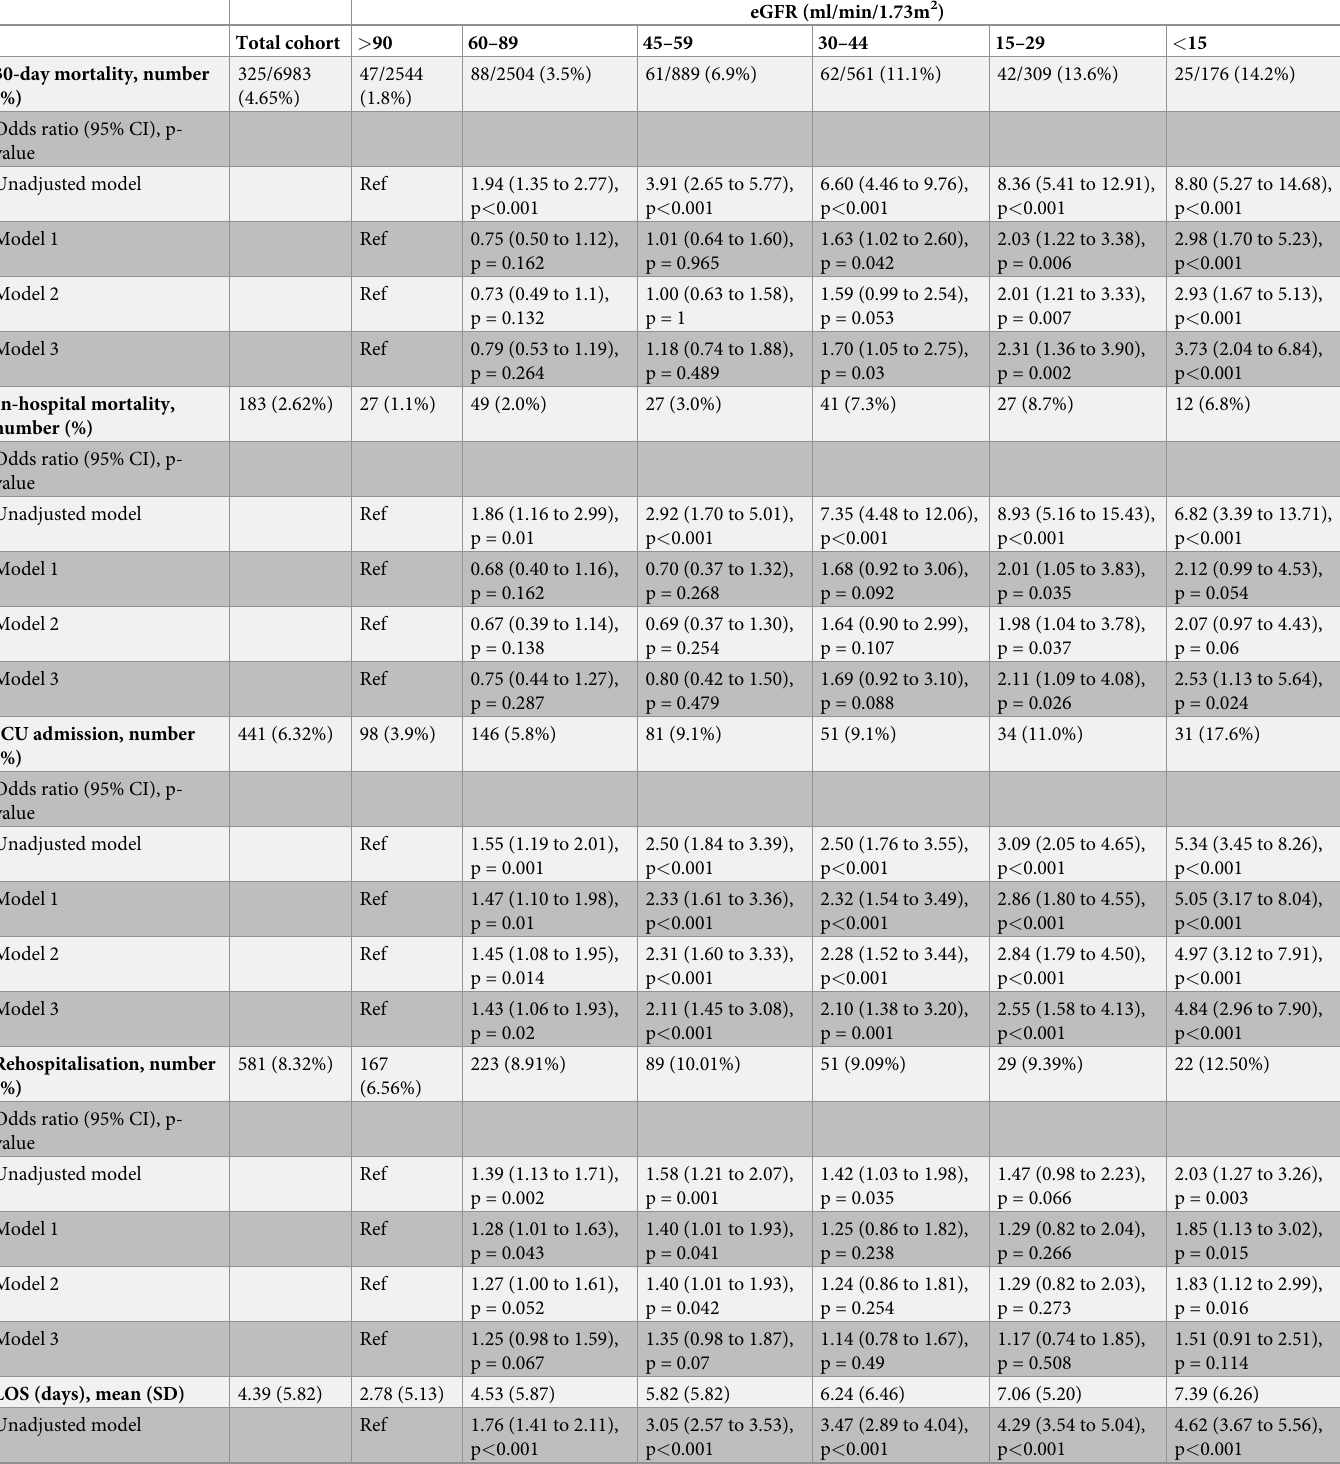
Table 2. Frequencies of primary and secondary endpoints according to eGFR groups and associations of eGFR stratified by groups with adverse clinical outcome in univariate and multivariate regression